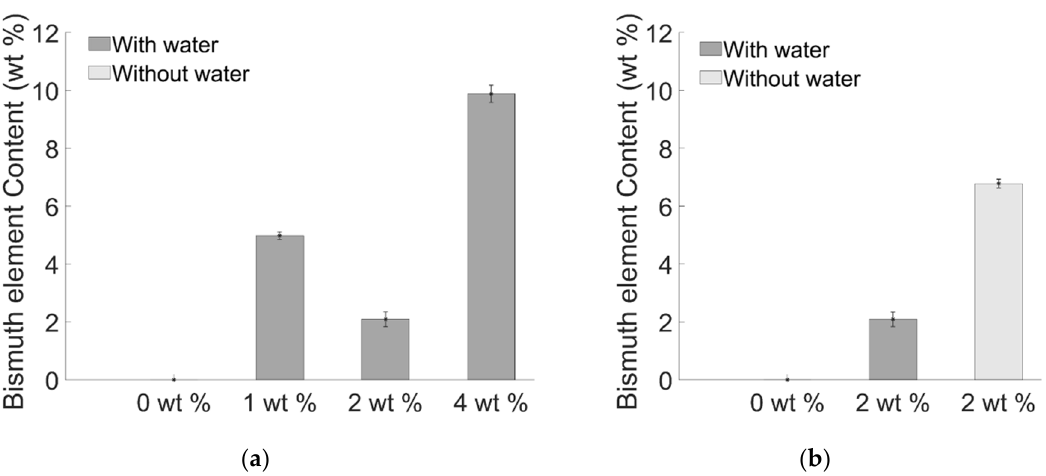
Figure 5. Histograms of EDS analysis on a surface of 4 µm 2 obtained for sample: ( a ) with water and ( b ) without water.